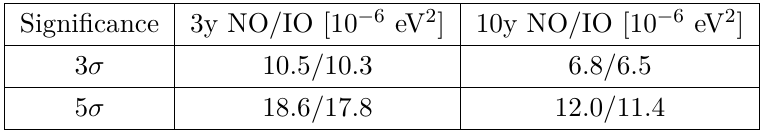
Table 6. Discovery potential for 3 and 10 years of data taking for both NMO